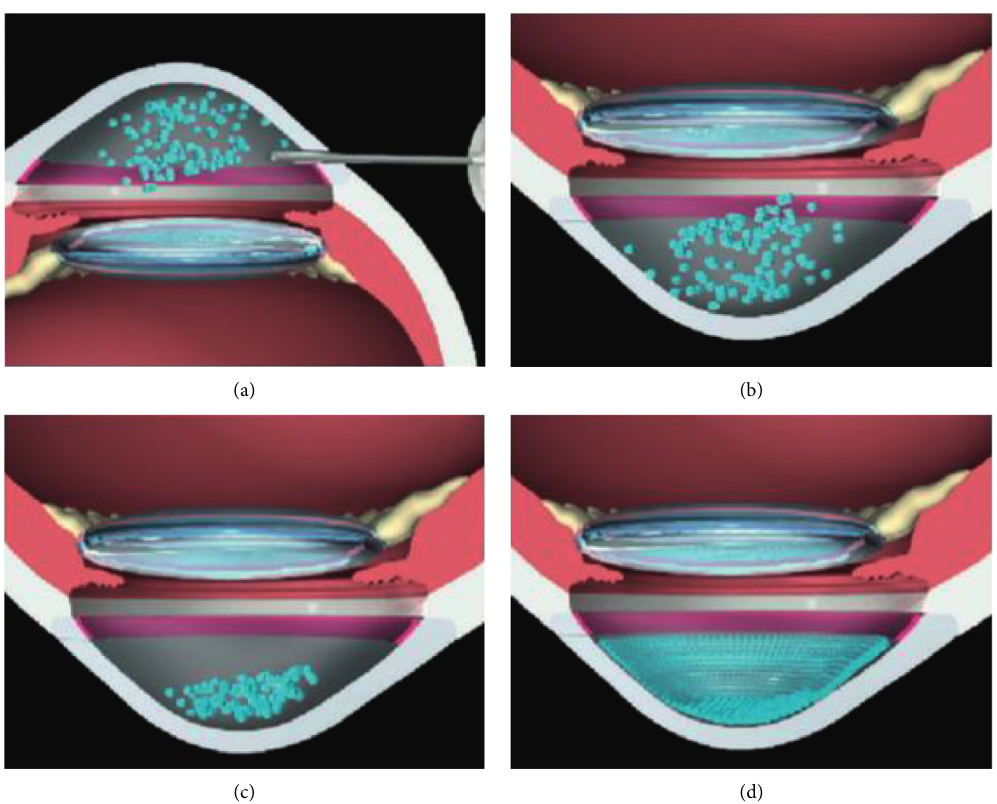
Figure 4: Future strategies for the treatment of endothelial diseases, from less invasive treatments to more invasive ones (based on the article by Okumura et al. [35]).